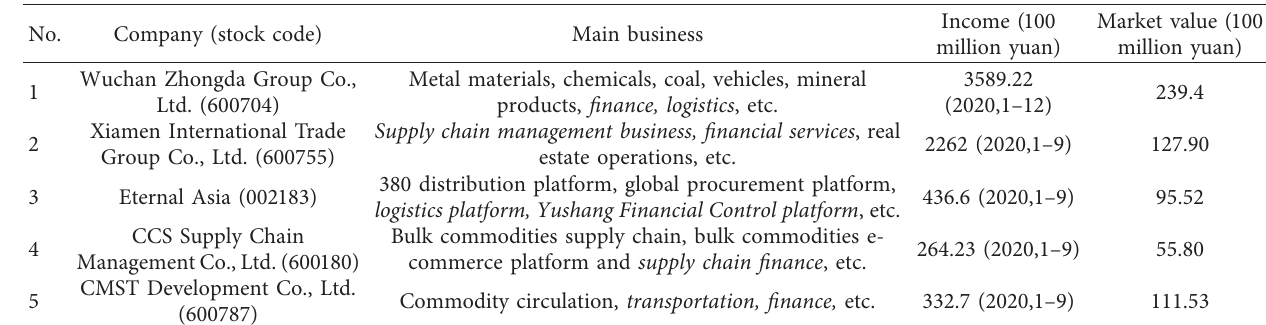
Figure 9: Changing of the transaction structure. Table 5: Other case